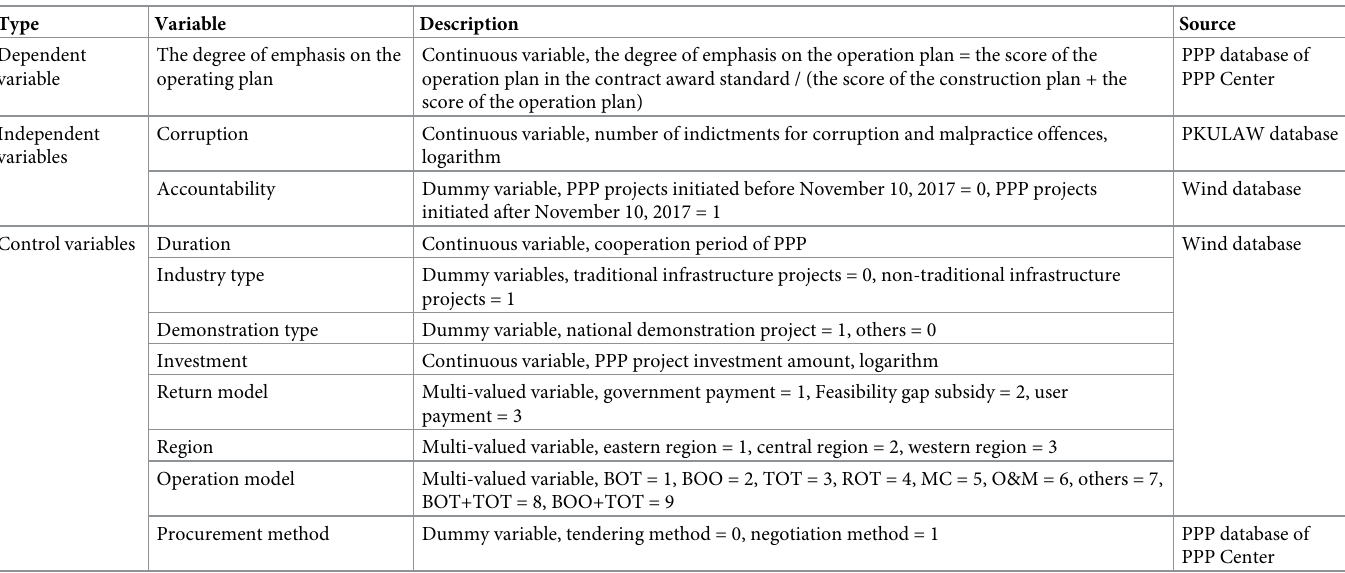
Table 1. Description of